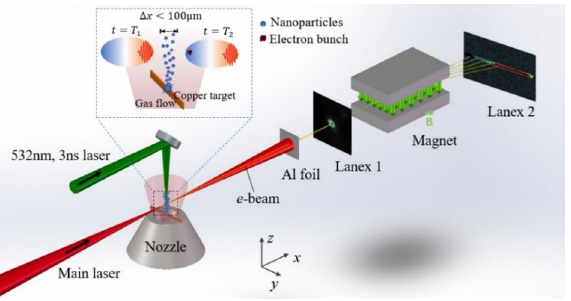
Figure 2. Experimental setup for the nanoparticle-based electron injection in LWFA. The main pulse drives a nonlinear plasma wakefield along the x -axis. A copper blade with a thickness of 100 μm is used as an ablation target inserting above the nozzle exit. A 3 ns green laser, propagating along the z- axis, is focused to the top surface of the copper blade to produce